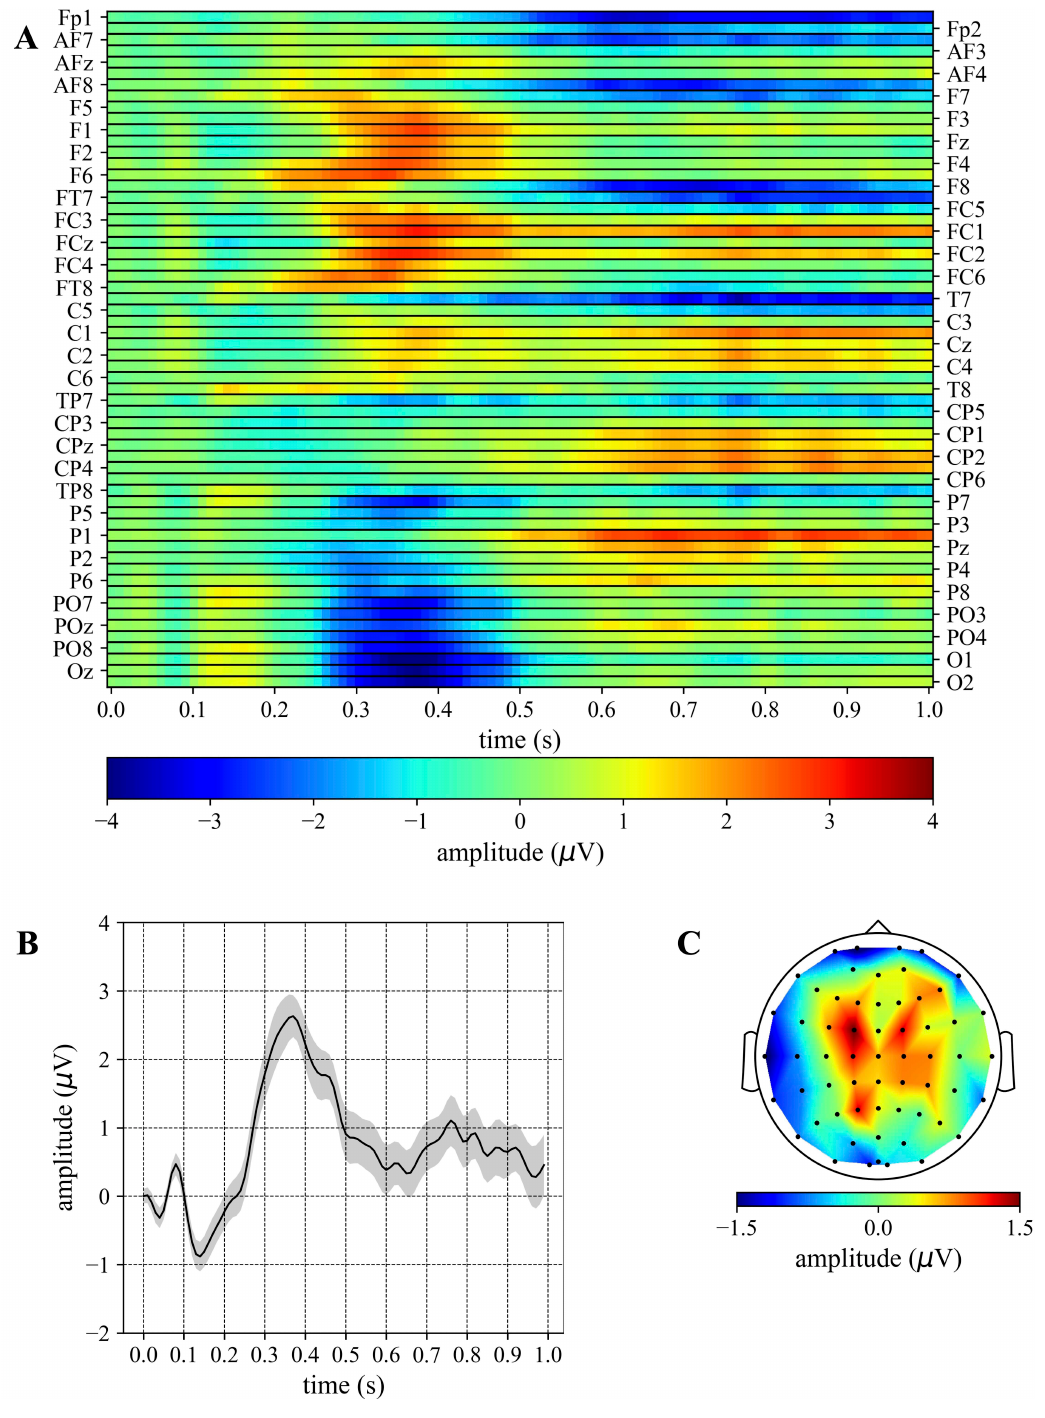
Fig. 4. Grand average ERP: distractor. (A) The grand average is reported as a 2D heatmap with electrodes and time steps along rows and columns, respec- tively. (B) The average temporal pattern obtained by averaging the 2D heatmap of (A) across the subset of electrodes showing more the P3a subcomponent (FC1, FC2, C1, C2, CP1, CP2). The shaded area represents the mean value ± standard error of the mean, while the thick line represents the mean value. (C) Topological representation of the average contribution of each electrode across all time samples of the 2D